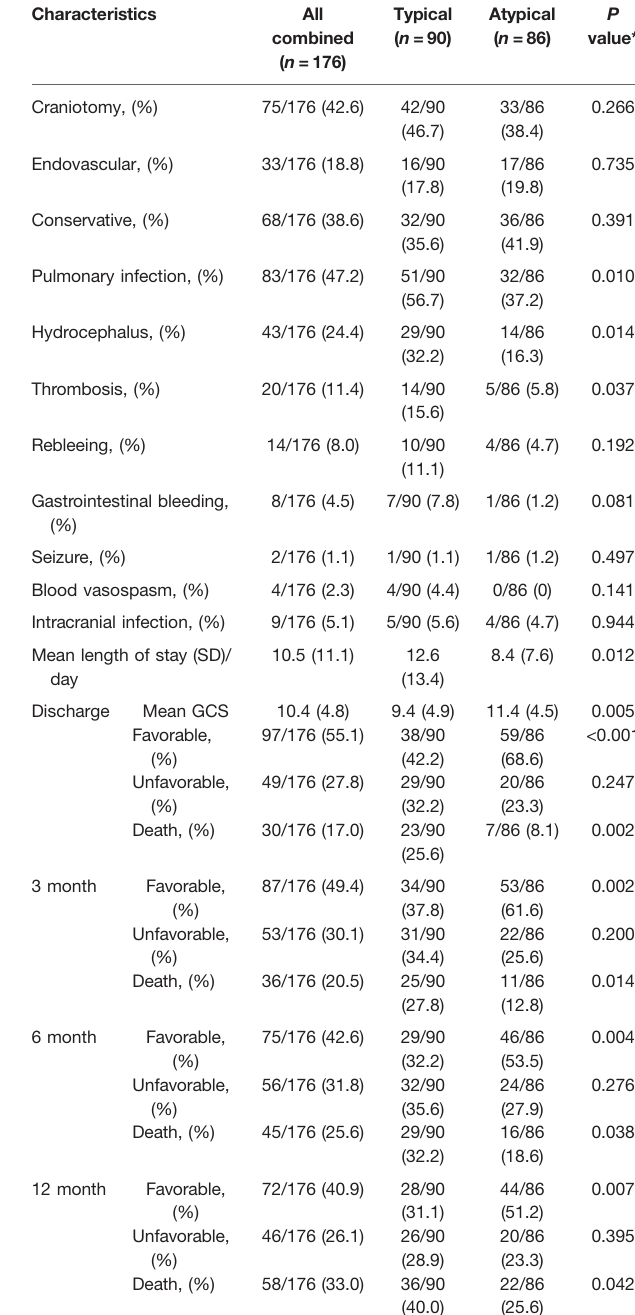
TABLE 4 | Treatment, complications and prognosis of elder patients with intracranial